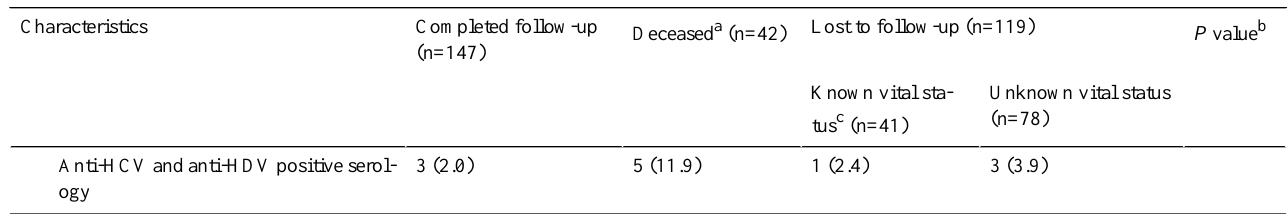
center before completing the third phase visit, 2 other or unknown reasons, and 22 with vital status determined by CépiDC. d ART: antiretroviral therapy. e Among patients with detectable viral loads.